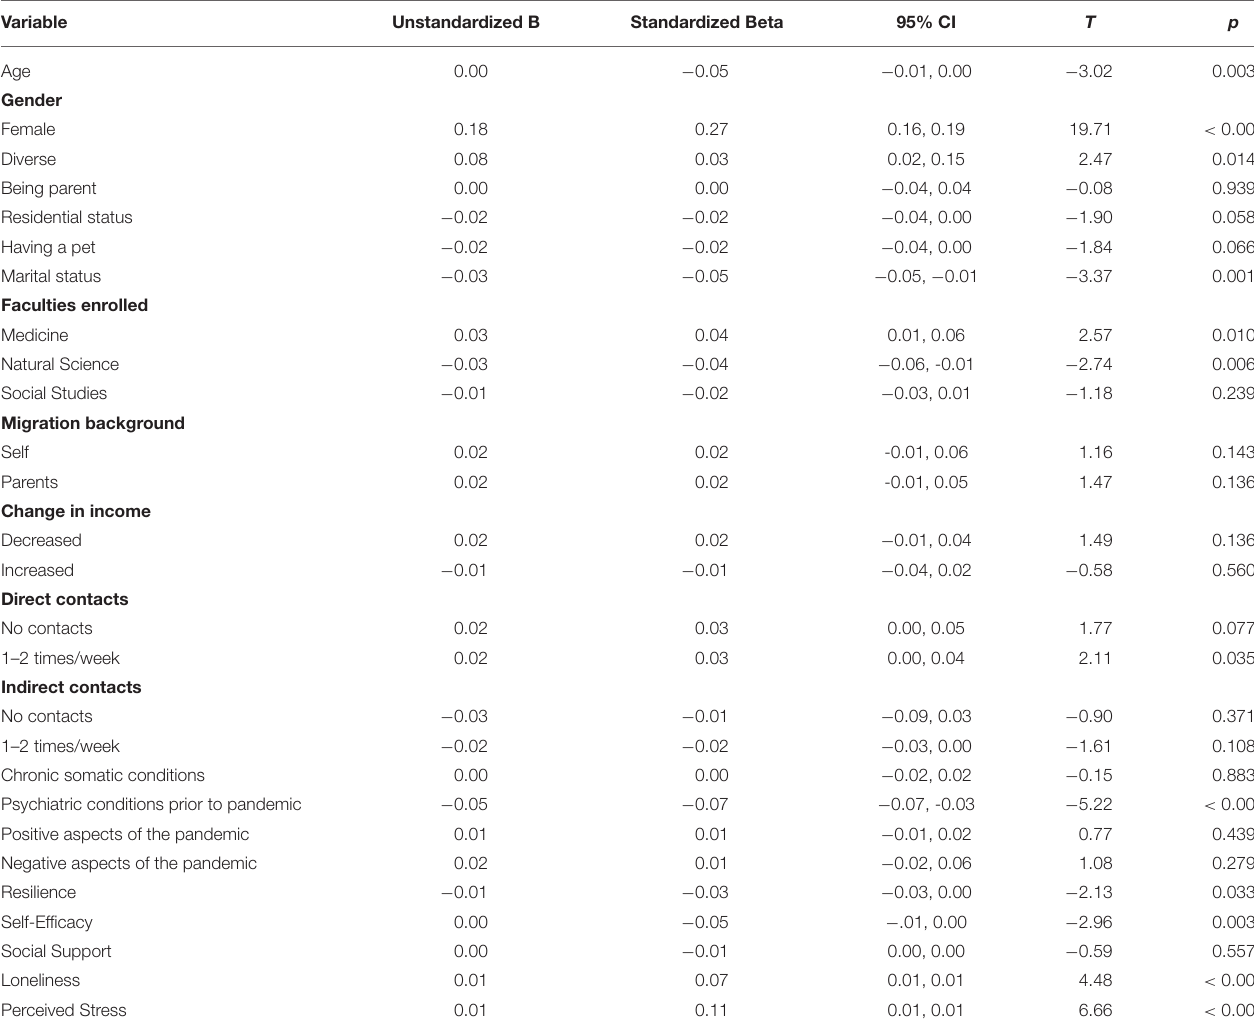
TABLE 5 | Linear regression analysis for predictors of anorexia nervosa symptoms measured by SEED (Short Evaluation of Eating Disorder).